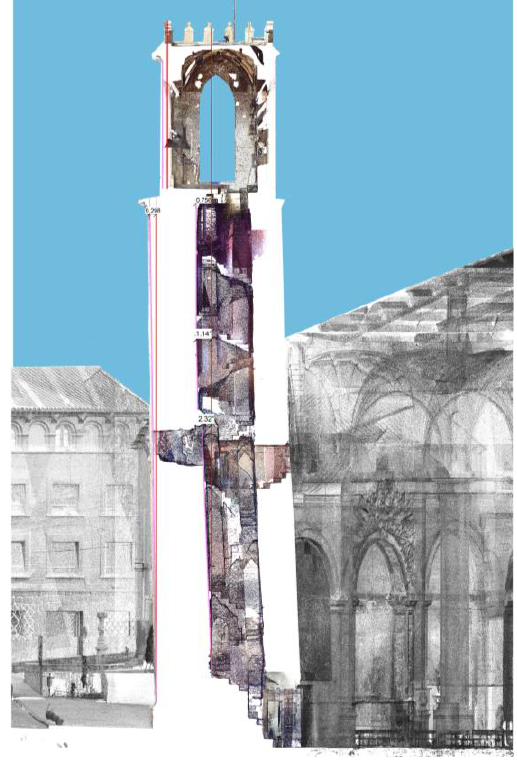
Figure 9. Inside and outside tilt of the bell tower with respect to the